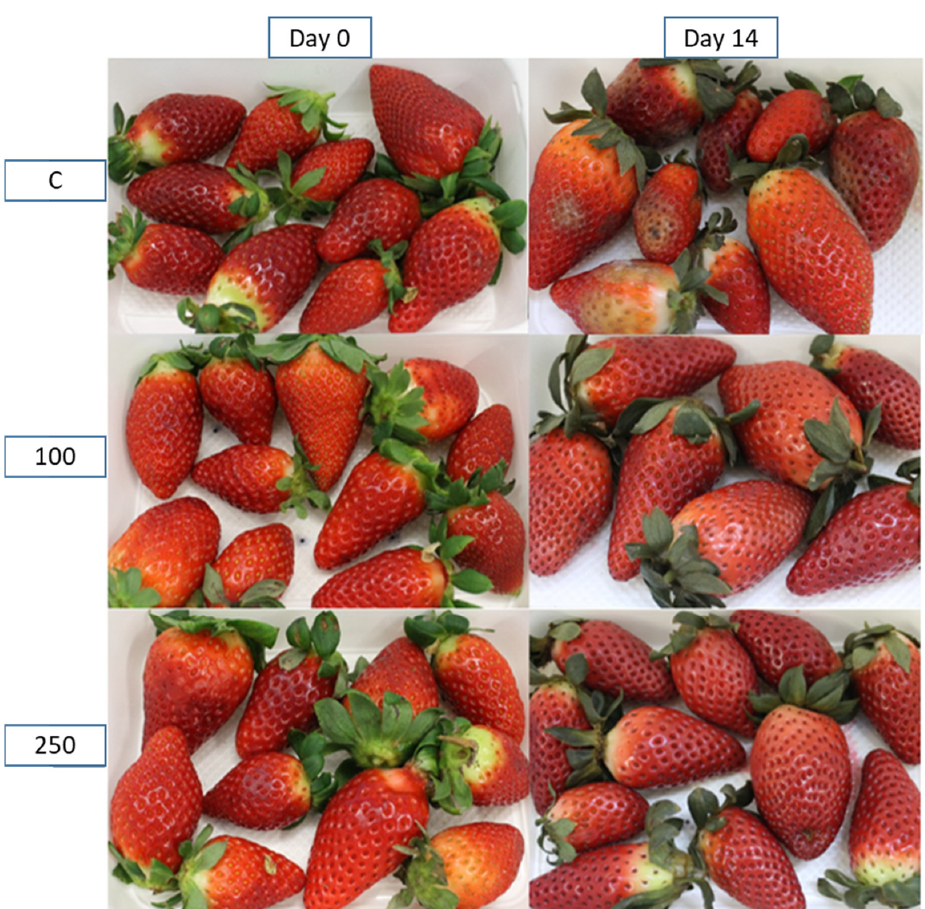
Figure 2. Representative images of strawberries packaged with control and active pads, at the beginning and the end of the storage period. From top to bottom: C, 100 and 250. Left side: day 0. Right side: day 14.